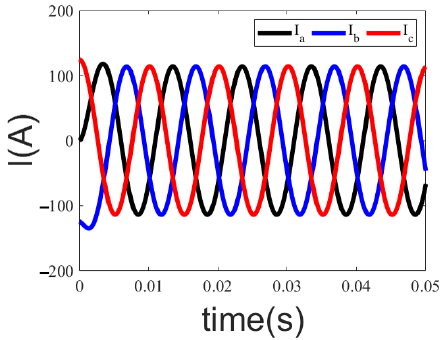
Figure 5. Normal Three phase current.